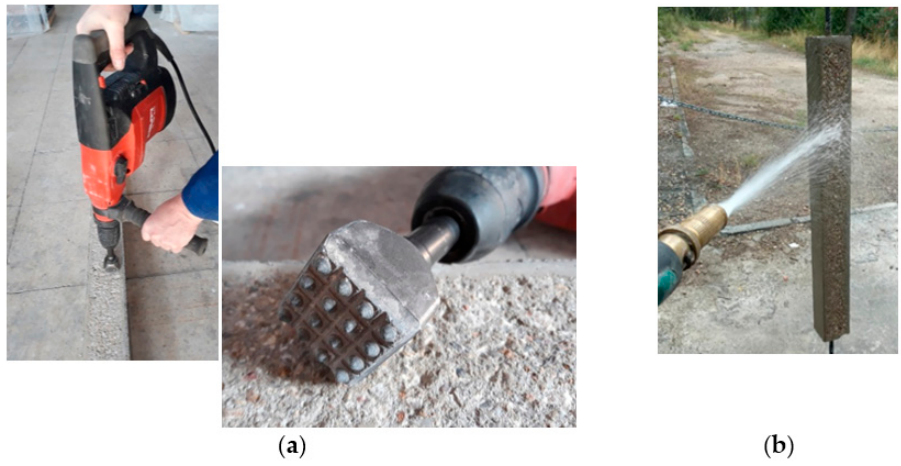
Figure 5. Overview of treatment on concrete surfaces: ( a ) Bush-hammering; ( b ) Surface cleaning. The specimens were stored in horizontal position, with the HPFRC layers at the bottom and top sides, in laboratory environment until the testing date. The tension tests were carried out 88 days after application of HPFRC, i.e., the total age of the conventional concrete was 148 days.